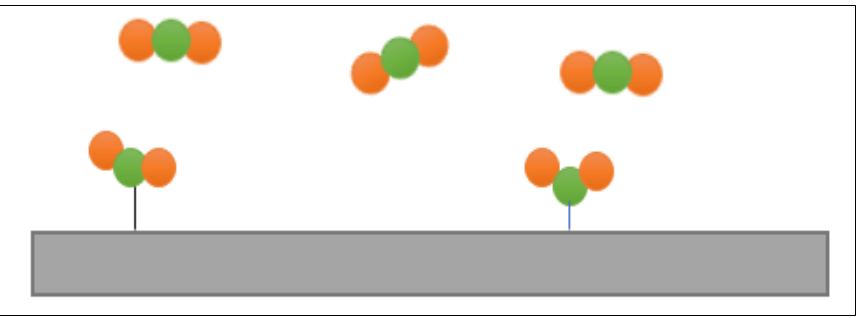
Figure 7. Illustration of chemisorption. Chemisorption can be measured by using standard free energy ( ∆ G 0 easily calculated using Equation (8), where K ads is the adsorption equilibrium constant, R is the universal gas constant, T is the absolute temperature, and 55.5 is the concentration of water.